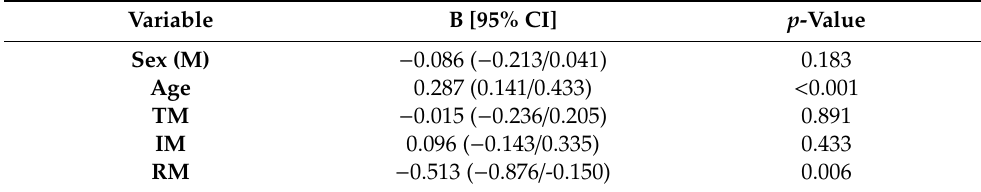
Table 4. Relation between patient’s characteristics and tacrolimus